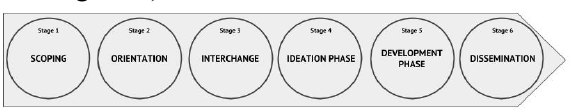
Figure 1 : Project